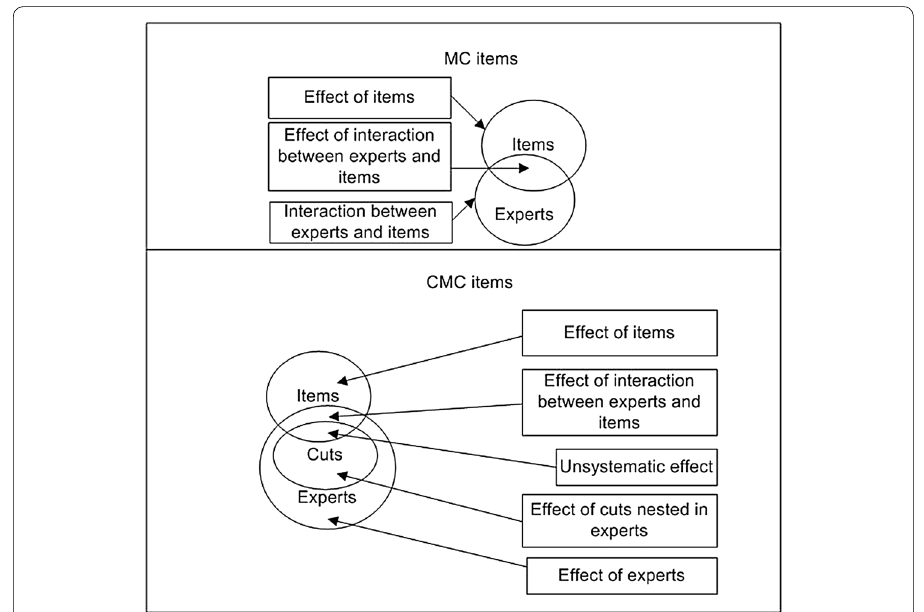
Fig. 1 Decomposition into systematic and unsystematic error terms in our G studies for MC and CMC items. MC multiple